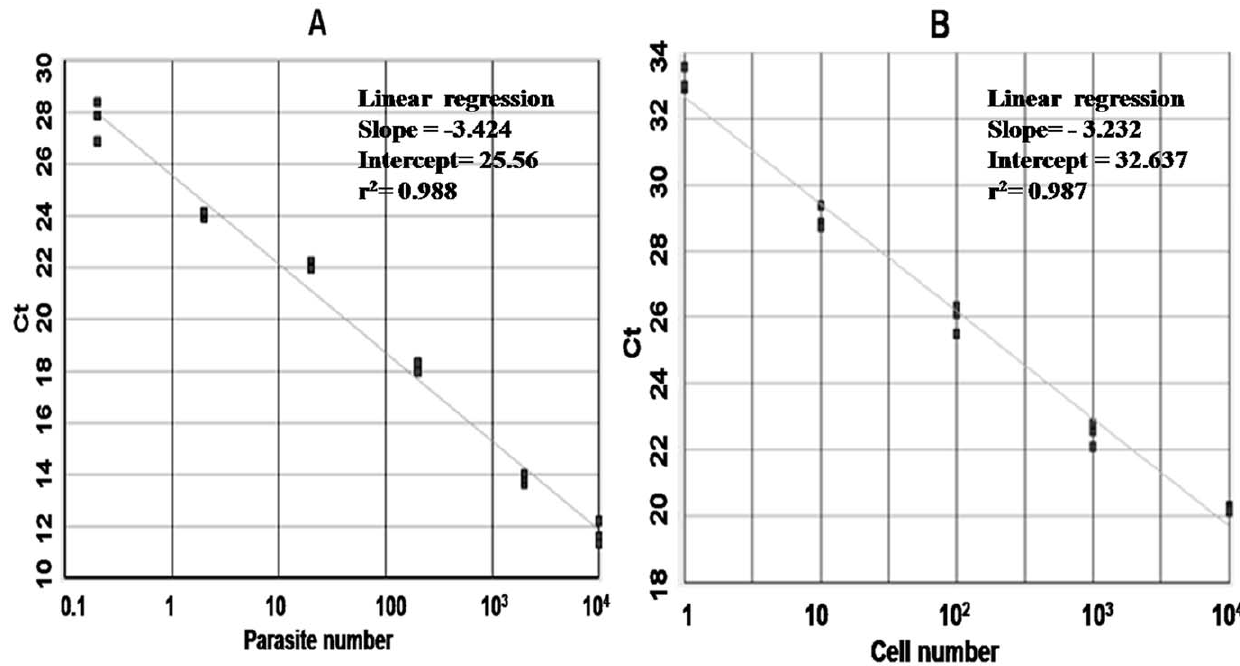
Figure 1. Standard curves obtained with SYBR Green 1 based real time PCR. (A) Amplification of Leishmania DNA expressed as the number of parasites per reaction. (B) Amplification of THP-1 cell line DNA expressed as the number of human nucleated cells per